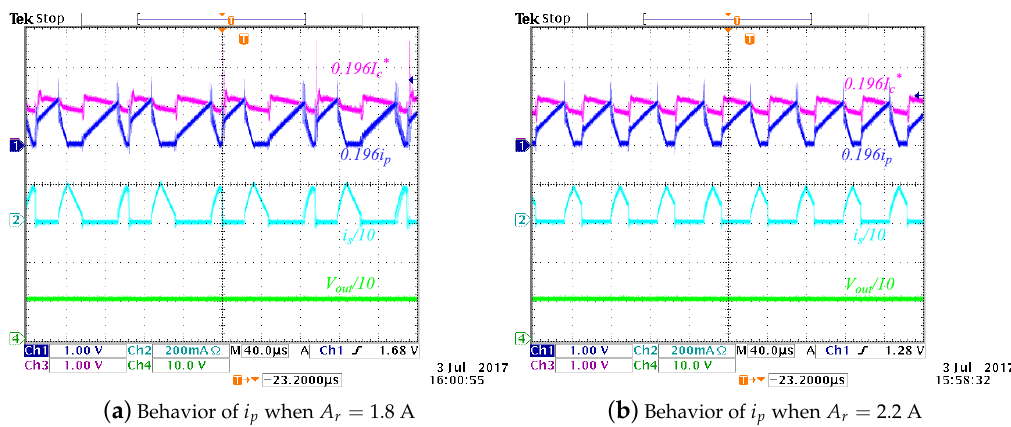
Figure 8. Experimental results with two different values of the compensation ramp for V ref = 100 V.